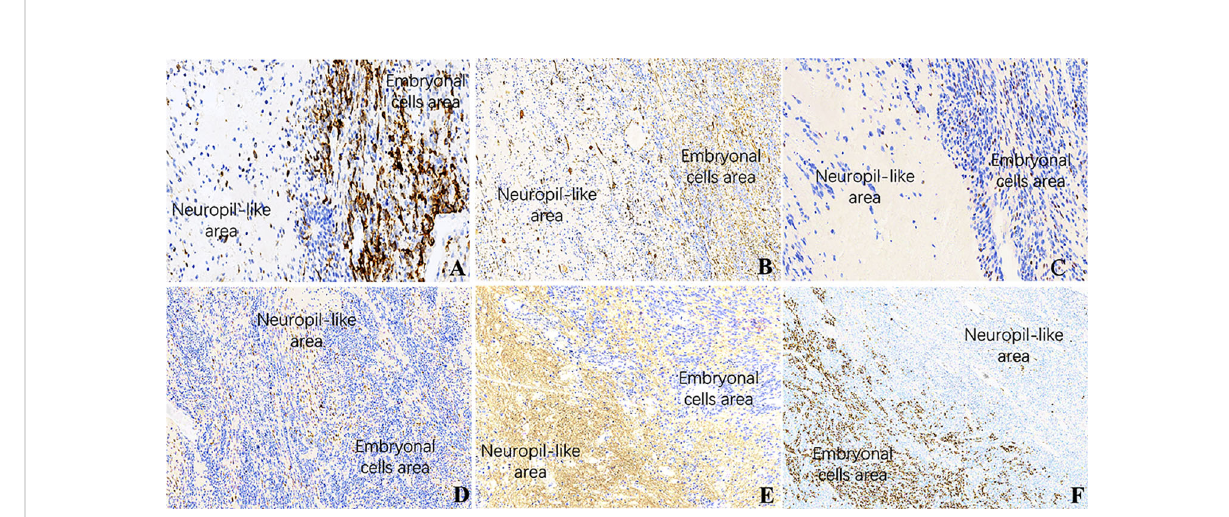
FIGURE 4 IHC of ETMRs for case 1, the expressions of (A) LIN28A, (B) GFAP, (C) OLIG2, and (F) Ki67 were stronger and more diffuse in the embryonal cell areas than in the neuropil-like matrix (×200); Neuronal makers, including NeuN (D) and Syn (E) , expressed in the neuron differentiated cells but were negative in embryonal cells